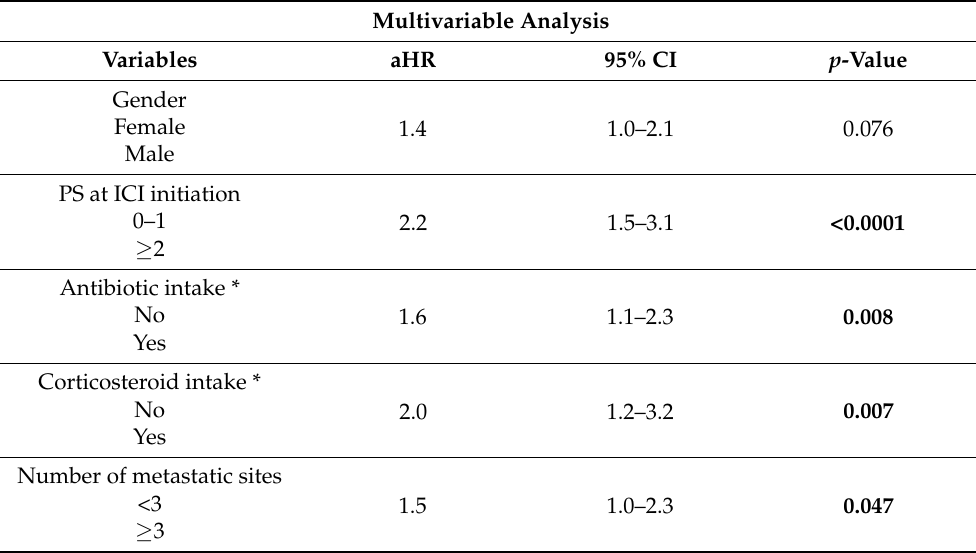
Figure 4. Overall survival according to treatment with antibiotics ( A ), corticosteroids ( B ), and LIPI score ( C ). ( A ) Kaplan–Meier overall survival curves according to treatment with antibiotics the month preceding ICI initiation or the first three months of ICI treatment (n = 79), or not (n = 114). Median OS in case of antibiotics intake history was 7.2 months (95%CI: 4.9–9.5) vs. 13.5 months (95%CI: 9.1–17.9) in patients without identified antibiotic intake ( p = 0.004, log-rank test). ( B ) Kaplan–Meier overall survival curves according to treatment with corticosteroids within the previous month before ICI initiation (n = 33) or not (n = 168). Median OS in case of corticosteroid treatment the month preceding ICI was 4.7 months (95%CI: 2.0–7.4) vs. 12.0 (95%CI: 8.5–15.4) in patients who did not receive corticosteroids before ICI ( p < 0.0001, log-rank test). ( C ) Kaplan–Meier overall survival curves according to LIPI score (low vs. intermediate vs. high score). The median OS for low, intermediate, and high LIPI scores were 15.3 months (95%CI: 9.8–20.8), 9.9 (95%CI: 6.6–13.2), and 5.8 (95%CI: 0.1–12.1), respectively ( p = 0.017, log-rank test). Table 2. Multivariable analysis by Cox proportional hazards for overall survival